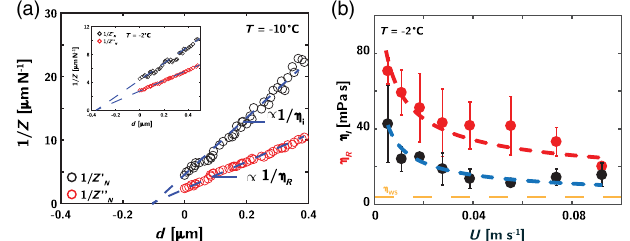
FIG. 3. Complex rheology. (a) Inverse of the mechanical impedance 1 =Z 0 N and 1 =Z 00 N as a function of the retract distance d for two distinct temperatures. We observe a linear behavior for both impedances, typical of a viscoelastic fluid. (b) Evolution of the real and imaginary parts of the viscosity as a function of the shearing speed U . The dashed lines correspond to a fit η R;I ∝ U − α with α ¼ 0 . 5 . The yellow line indicates the viscosity of super- cooled water η . WS